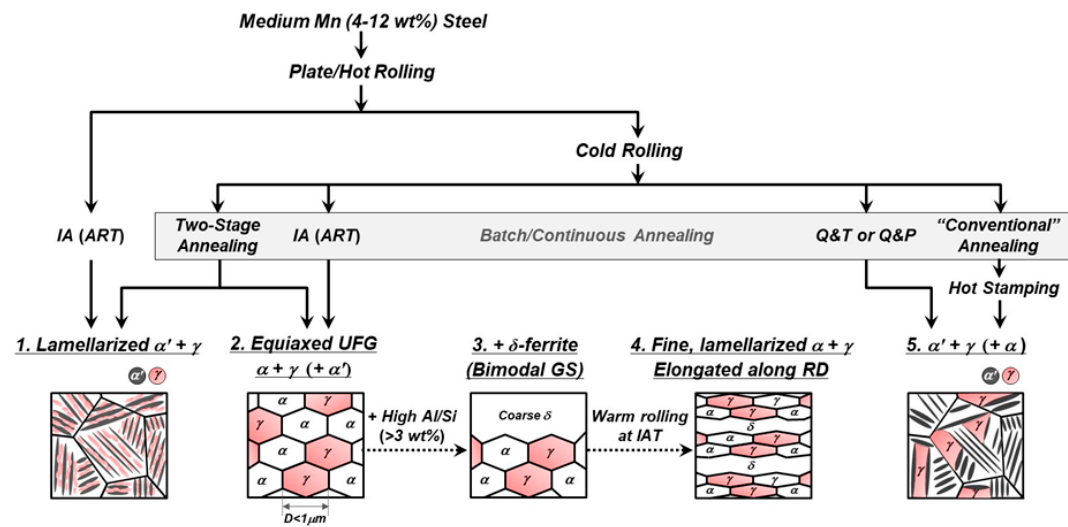
Figure 1. Schematic of representative thermo-mechanical processing routes for medium-Mn steels and the resulting microstructures. IA, intercritical annealing; ART, austenite-reverted transformation; Q&T, quenching and tempering; Q&P, quenching and partitioning; UFG, ultra–fine–grained; α′ , α′ –martensite; γ , austenite; α , α –ferrite; and δ , δ –ferrite.